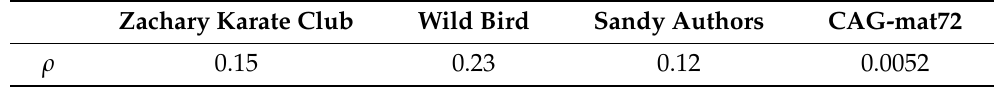
Table 1. Different ρ for each test network.